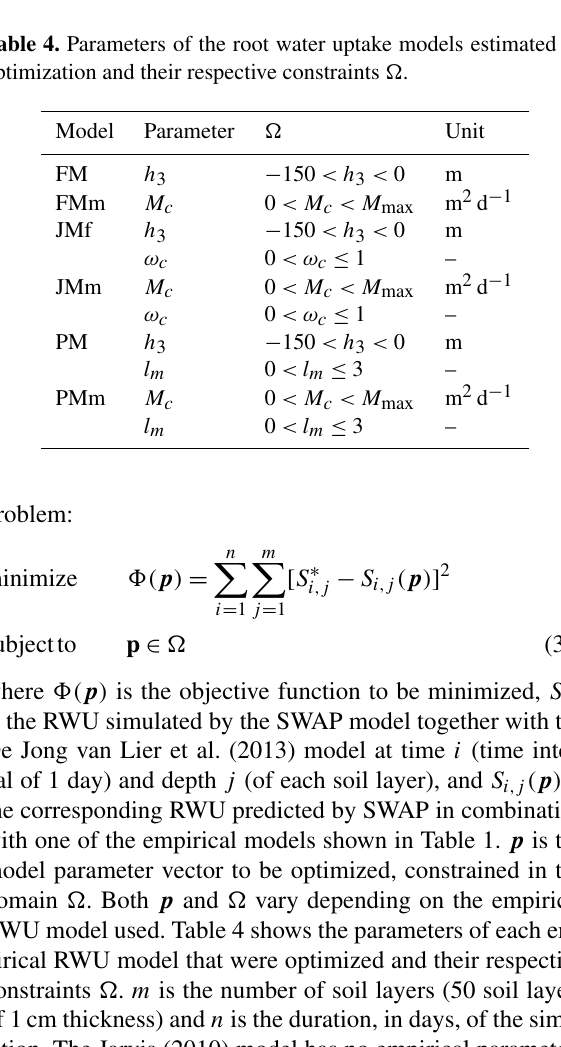
runs of SWAP with each empirical model using random